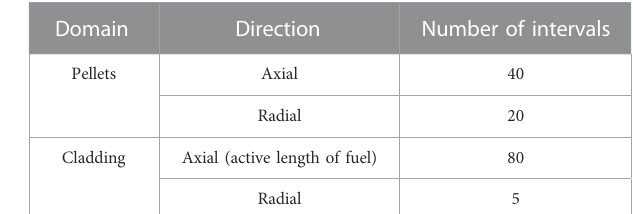
TABLE 3 Fuel rod mesh parameters used by fuel performance analysis